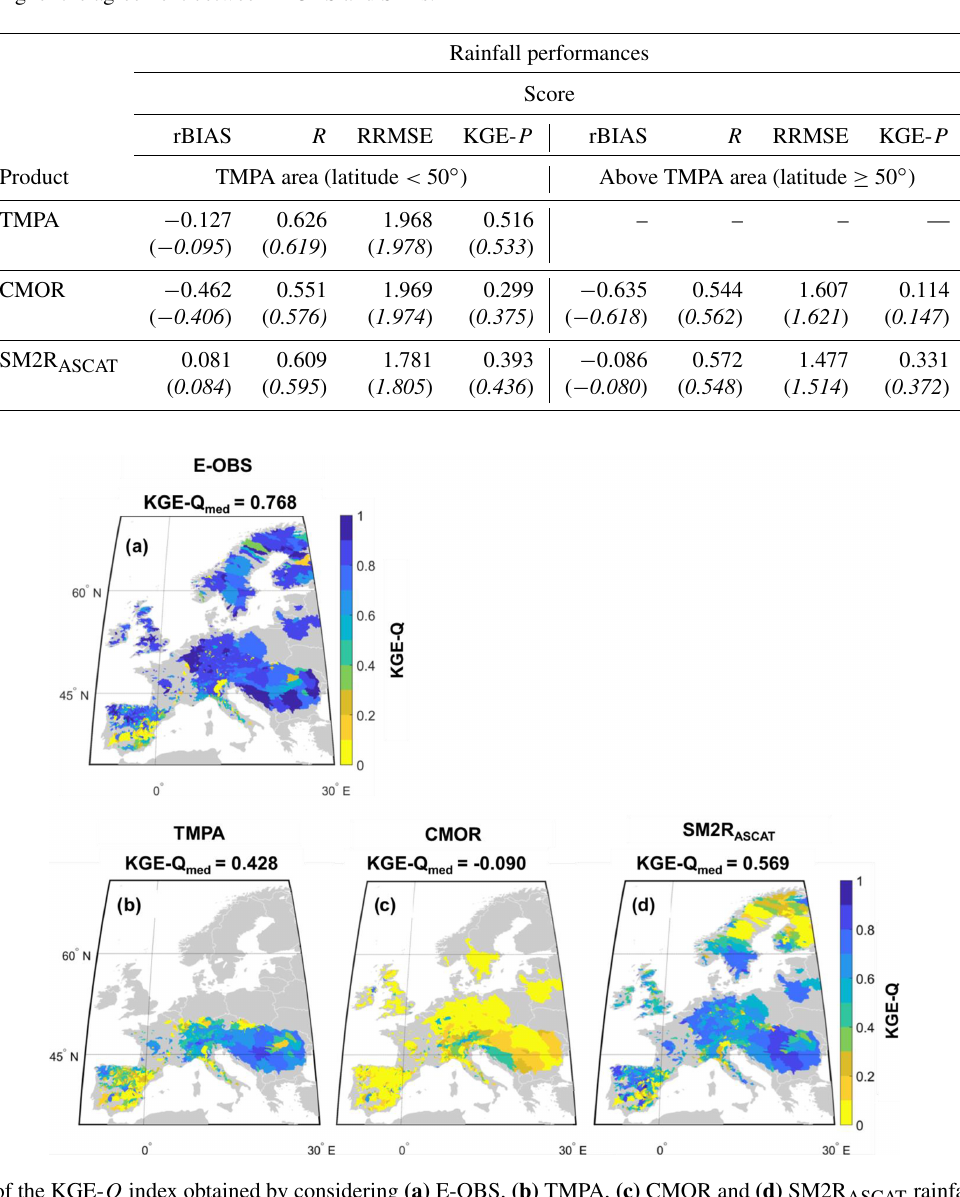
Table 2. Performance scores for rainfall (in terms of rBIAS, R , RRMSE and KGE- P ) time series computed during the calibration (in italics) and the validation periods. Rainfall performances are evaluated with respect to E-OBS rainfall data and distinguished between basins whose outlet section is below or above 50 ◦ latitude. It has to be noted that the more rBIAS, R , RRMSE and KGE- P values go toward 0, 1, 0 and 1, respectively, the higher the agreement between E-OBS and SRPs.